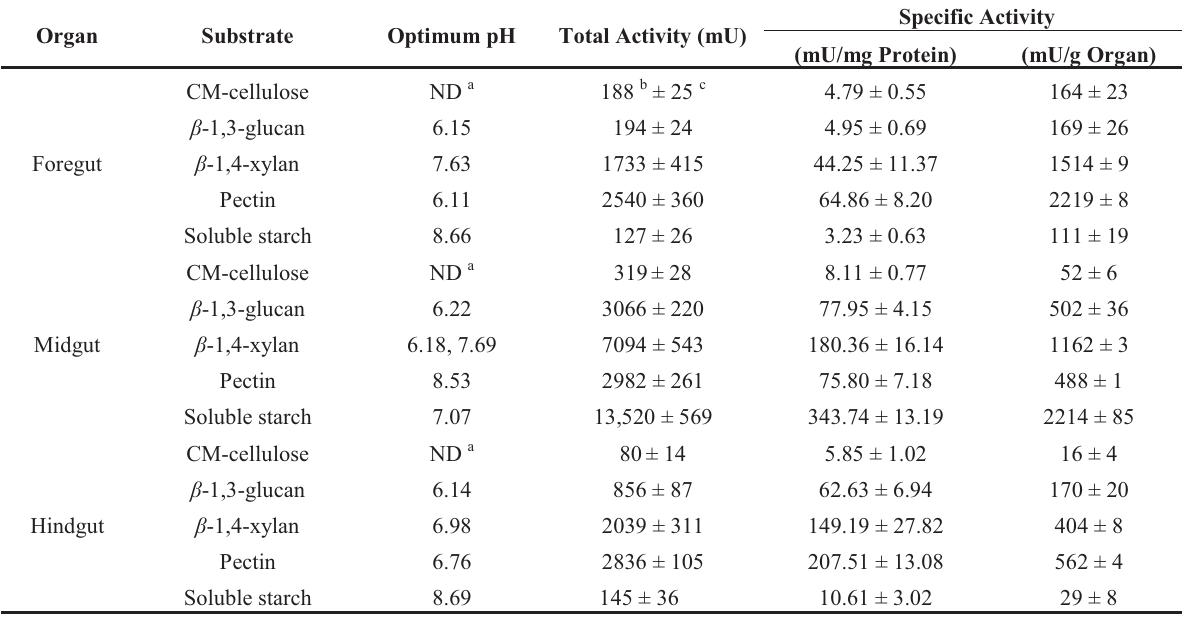
Table 1. Glycanase activities from the larval digestive tract of the T. dichotomus. Organ